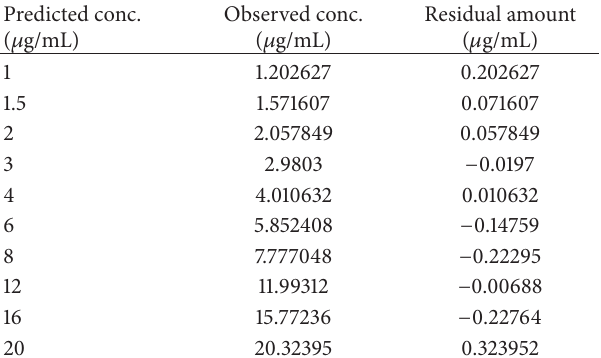
Table 2: Test for residuals.